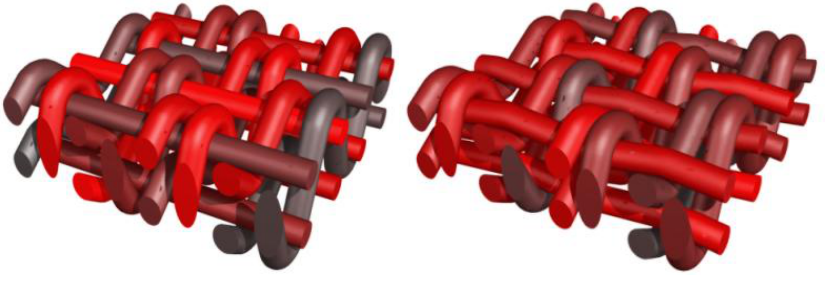
Figure 9. Generation of a reinforcement scheme with two families of warp yarns alternating on respectively one and two sets of weft yarns; ( a ) fully tensioned weft yarns; ( b ) effect of a decrease in weft yarns tension; ( c ) further decrease of the weft yarns—axonometric view; and ( d ) further decrease of the weft yarns—side